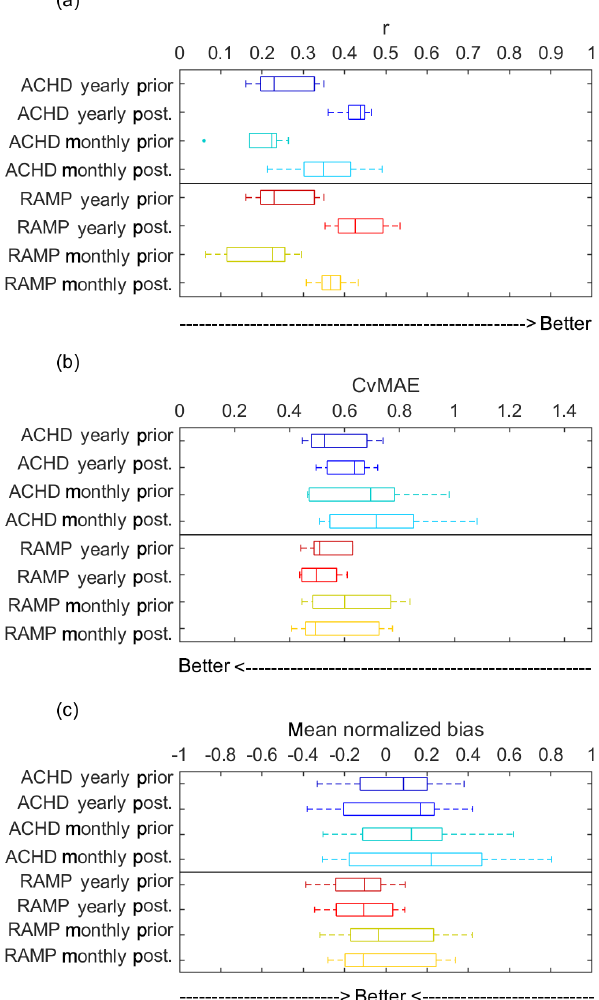
Figure 3. Comparison of performance metrics ( a correlation, b Cv- MAE, and c MNB) for surface PM 2 . 5 estimated from satellite AOD data in the Pittsburgh area. Performance is assessed at the ACHD regulatory-grade monitoring sites. Ground sites used for factor de- velopment are either four of the ACHD monitors (ACHD) or four low-cost sensors associated with RAMP monitors (RAMP). Con- version factors are established either on a yearly or monthly